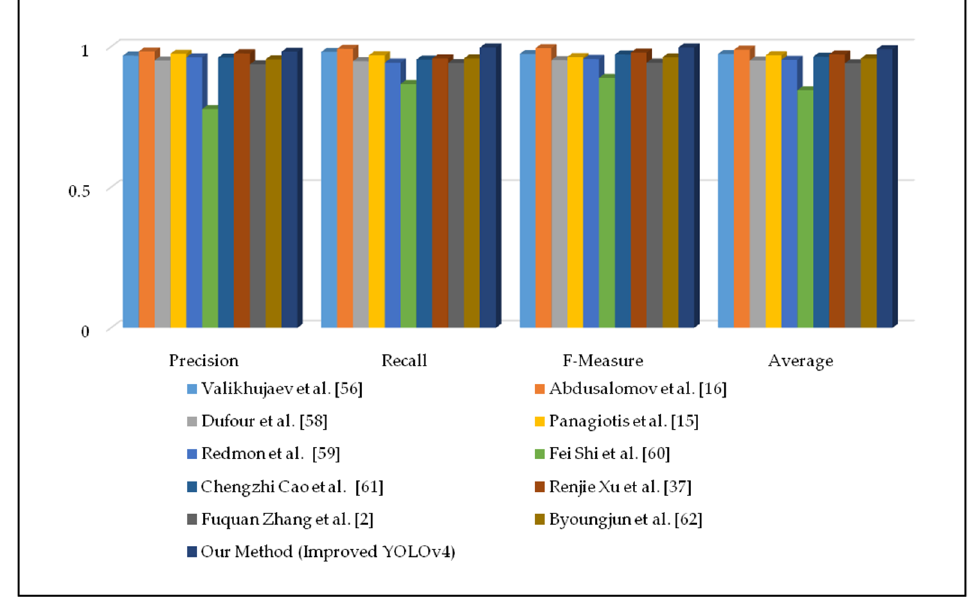
Figure 8. Quantitative results of fire detection approaches using vertical graphs.